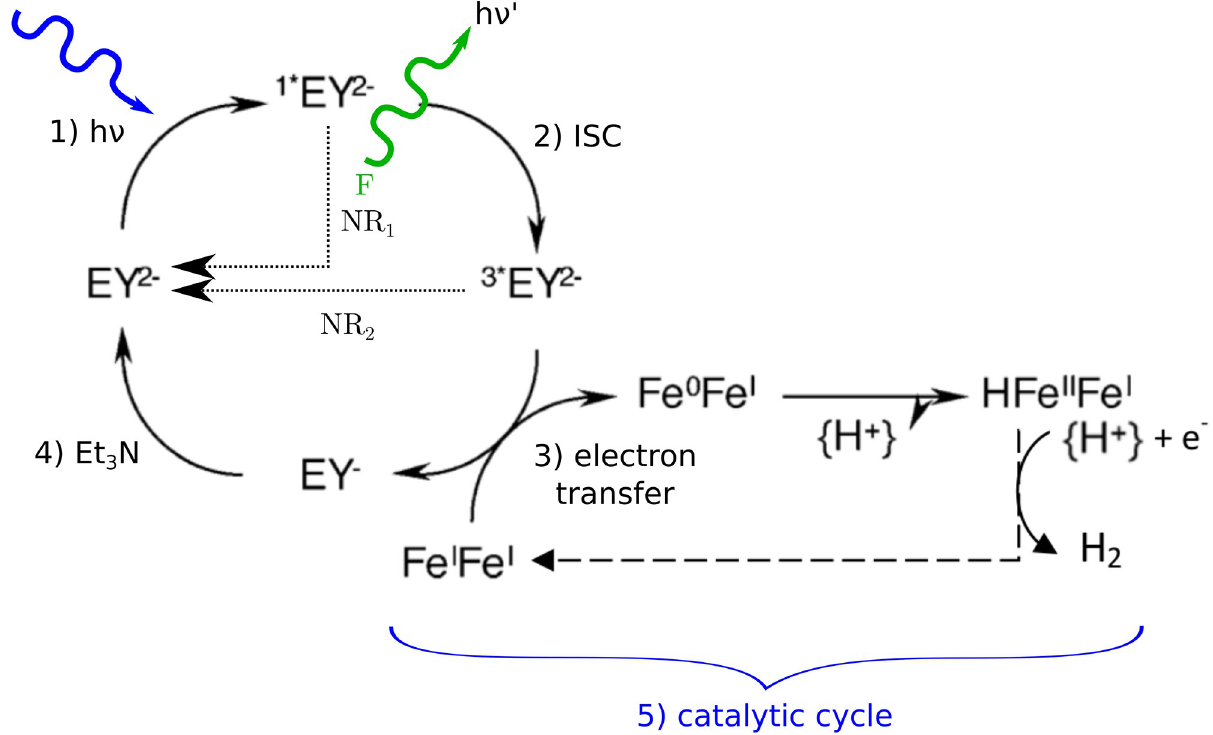
Fig 4. Proposed mechanism. Hydrogen production with the fluorescent photocatalytic system in homogeneous phase [21, 51, 52].